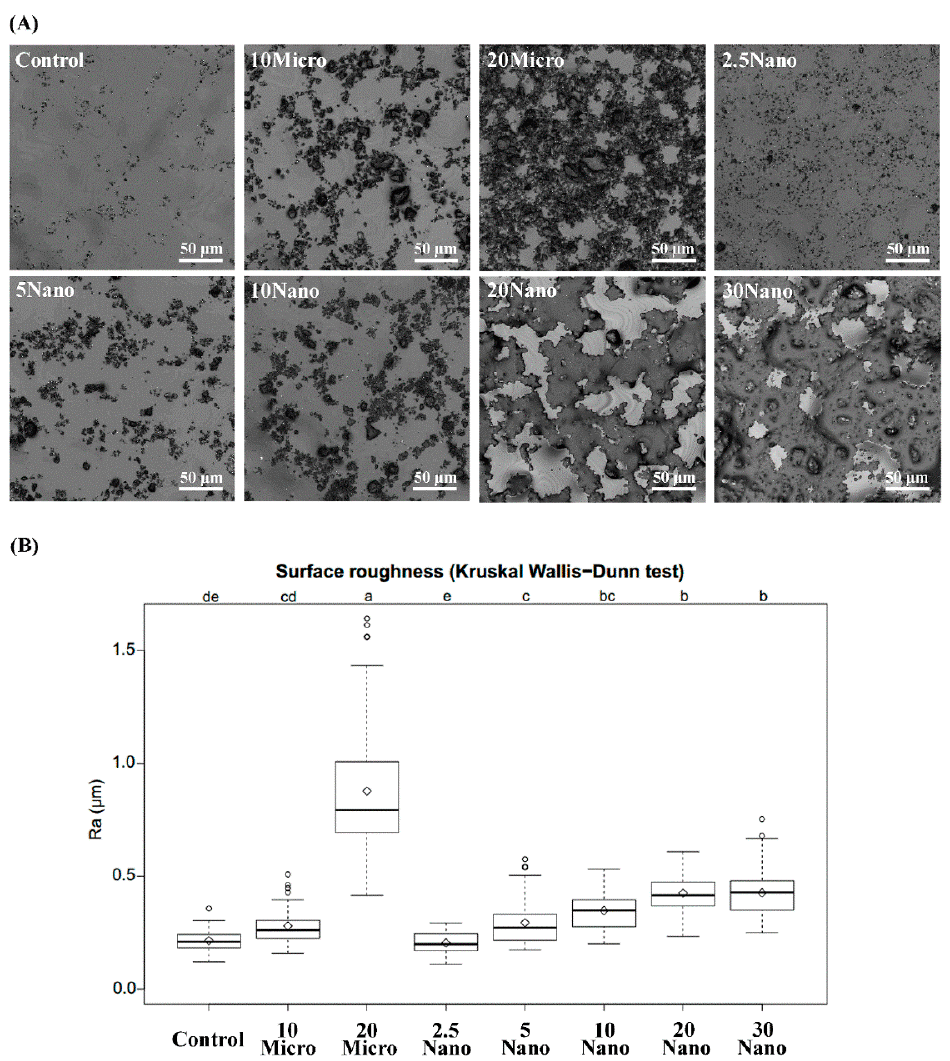
Figure 5. ( A ) Laser scanning micrographs illustrating the surface detail of different tissue conditioners. ( B ) Boxplots of surface roughness measured for different tissue conditioner specimens. Different letters above the plots indicate significant differences.